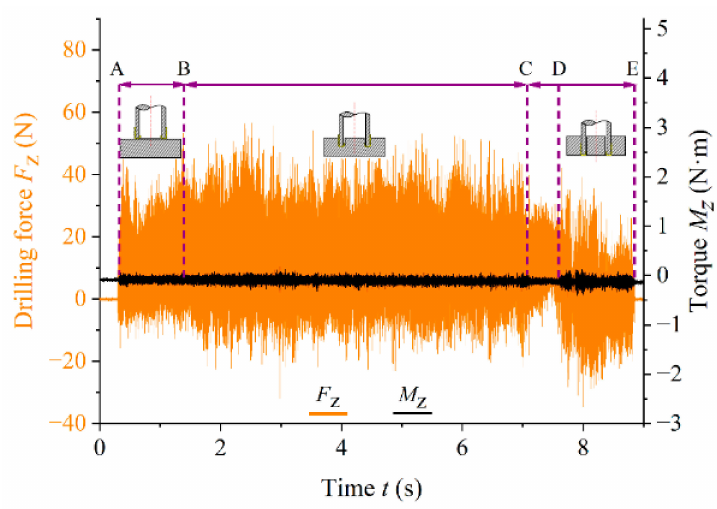
Figure 7. Drilling force and torque signals.